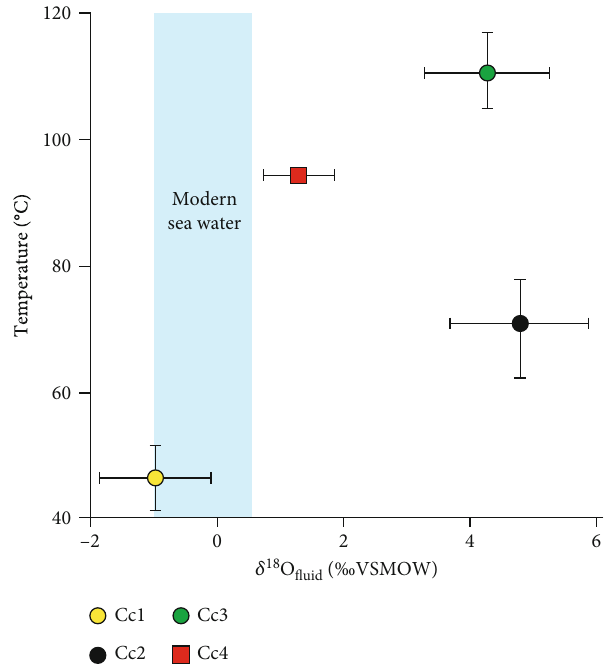
‰ VSMOW) calculated fl uid (